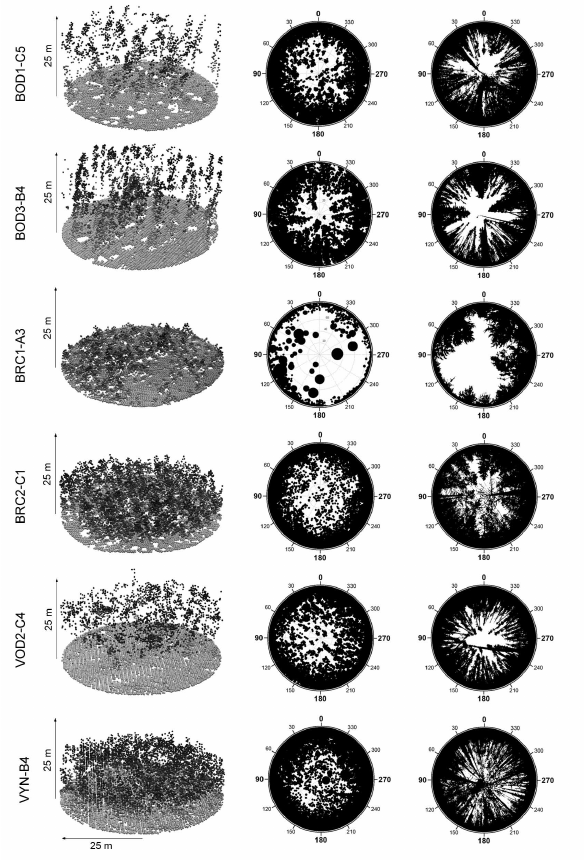
Fig. 4. Representative examples of ALS point clouds (left), ALS synthetic hemispherical images (centre) and real optical hemispher- ical photographs (HP) (right) for each stand; azimuths ( ◦ ) are shown on the hemispherical